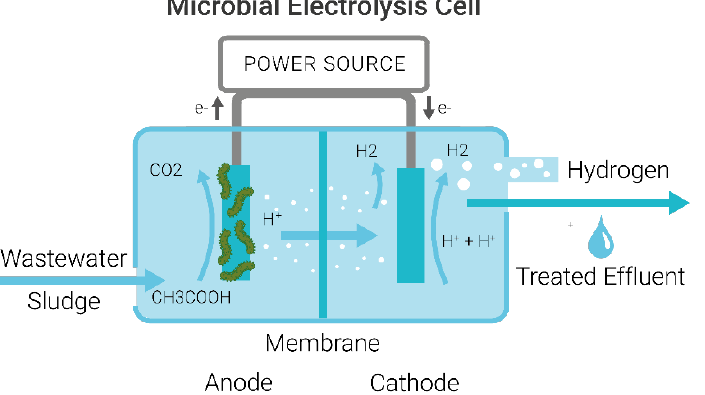
Figure 1. Schematic of a Microbial Electrolysis Cell for treating wastewater to produce H 2 , showing the wastewater influent and effluent and an anode and cathode separated by a membrane and connected to a power source.